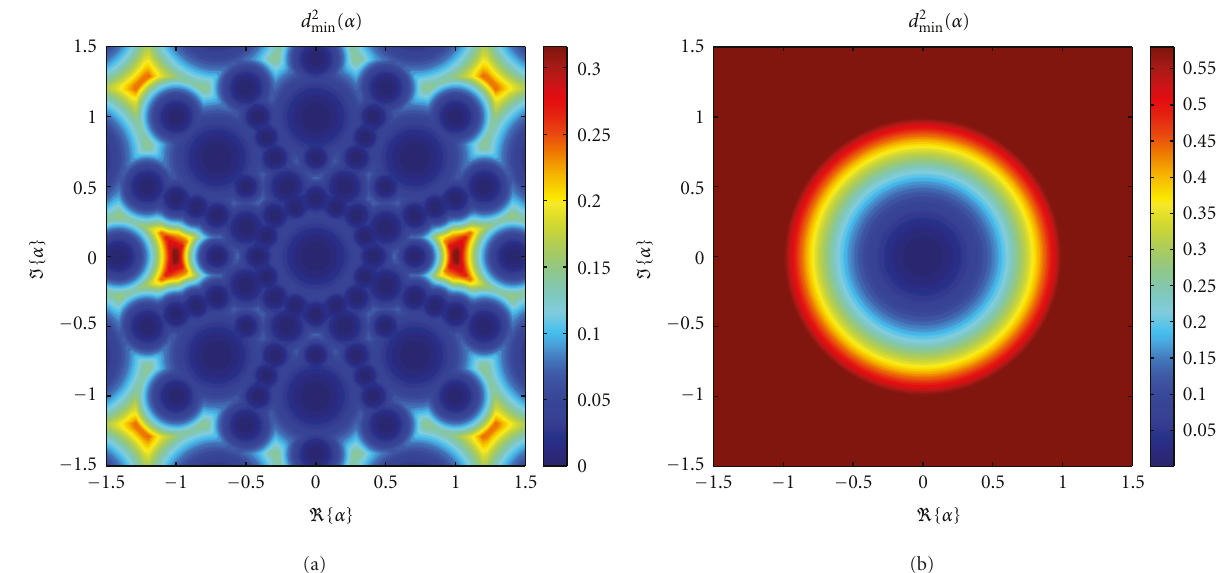
Figure 9: Hierarchical minimum distance performance for 8-PSK and 8-ary example codebook (zero mean).